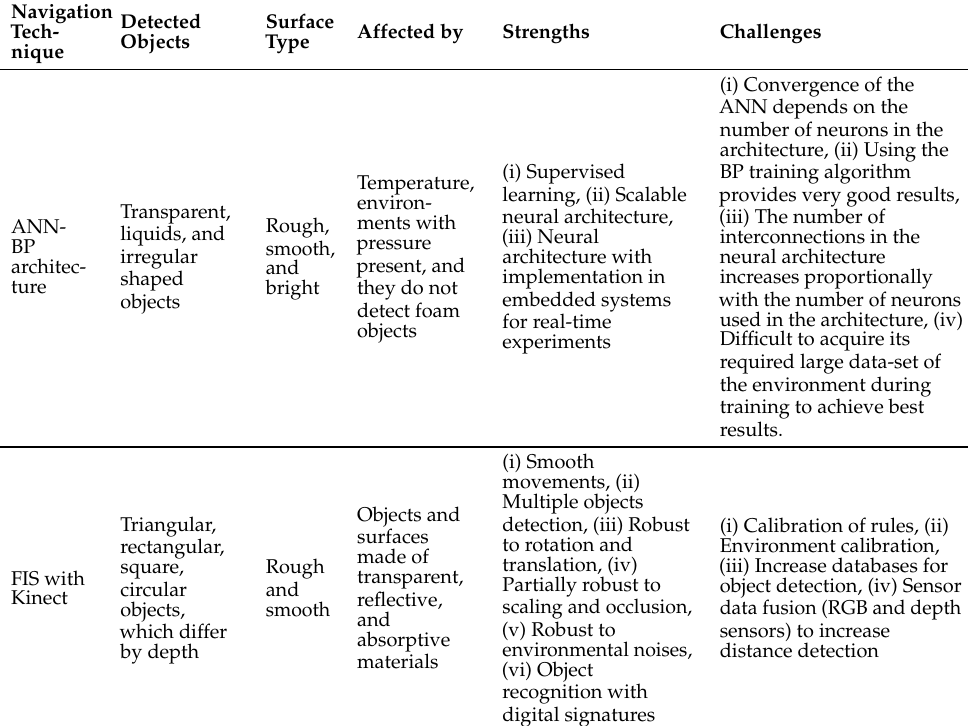
Table 6. Comparison of reactive Obstacle–Avoidance